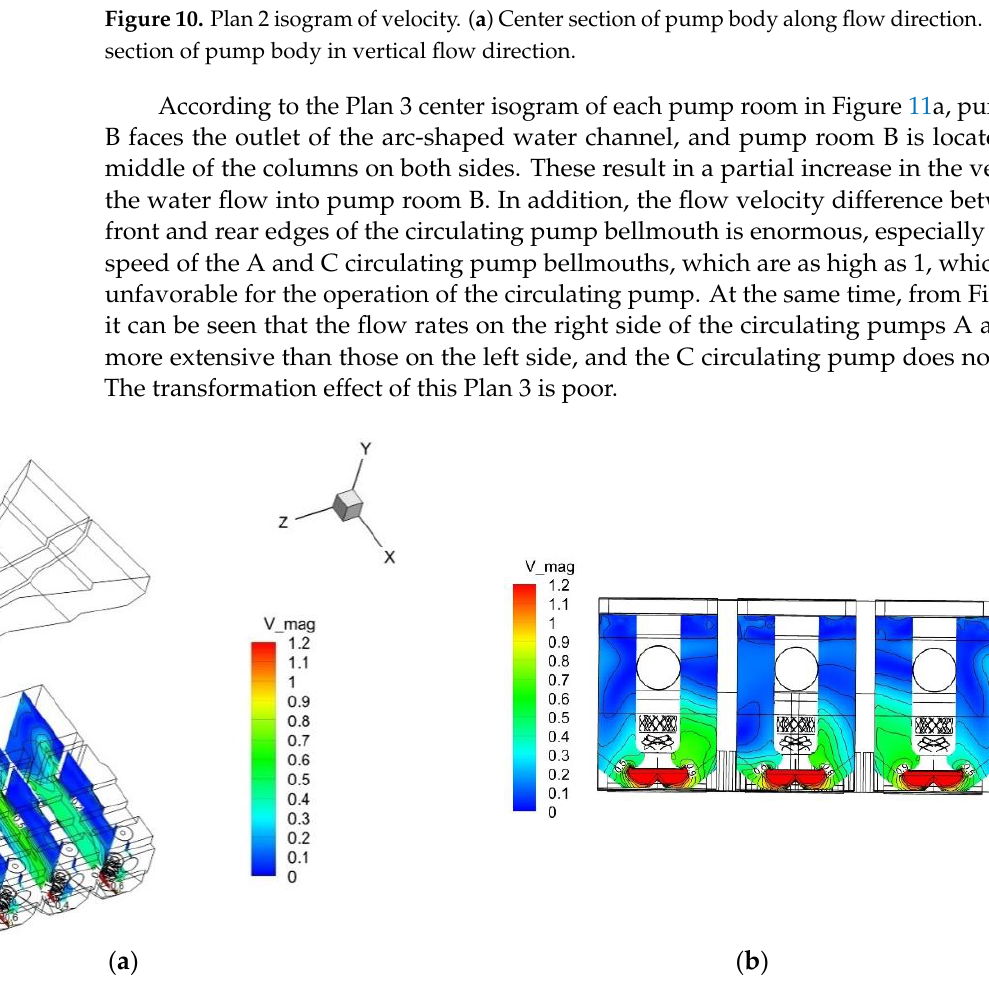
Figure 11. Plan 3 isogram of velocity. ( a ) Center section of pump body along flow direction. ( b ) Center section of pump body in vertical flow direction.